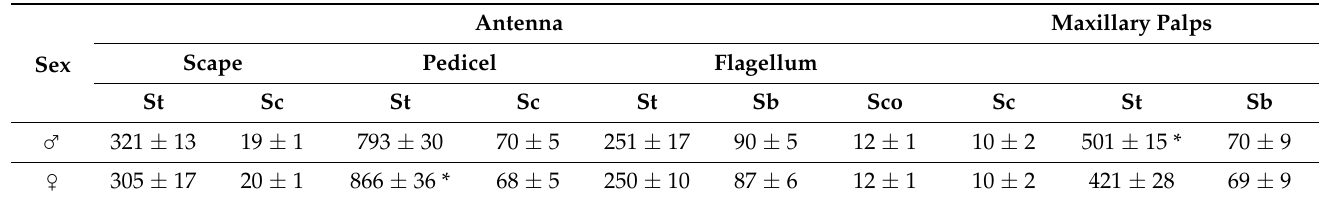
Table 1. Abundance and distribution of sensilla on B. dorsalis antennae and maxillary palps. Antenna Maxillary Palps Pedicel Flagellum Sex